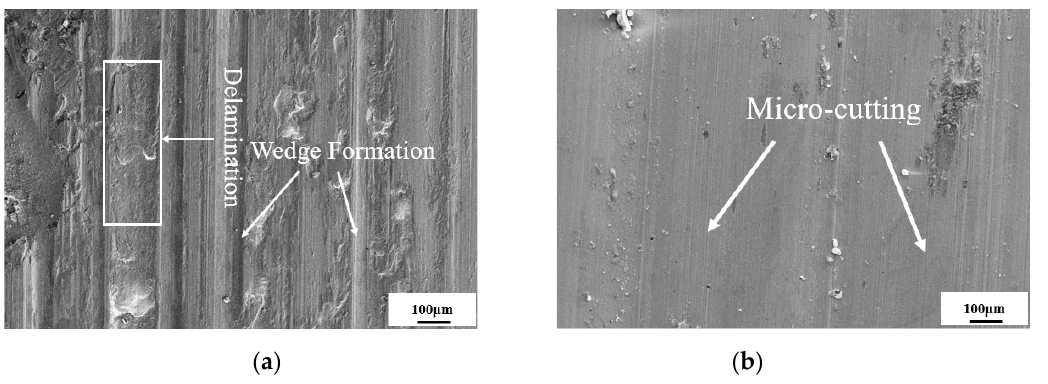
Figure 13. Wear sample morphology: ( a ) 65 Mn sample; ( b ) 1600 W coated sample.